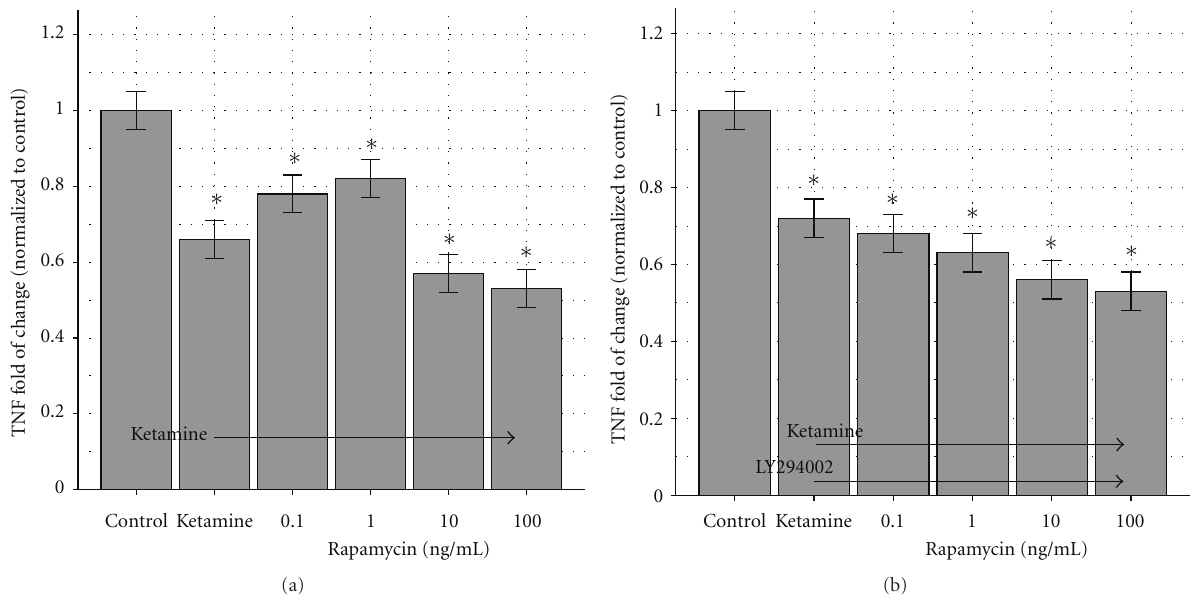
Figure 5: (a) Ketamine and rapamycin modify TNF production by RAW264.7 murine macrophages. LAC wild-type MRSA (USA300) stimulated 34% less TNF secretion by macrophages when exposed to ketamine (second column), and 43% and 47% less than the control (first column) when exposed to a combination of ketamine and rapamycin at 10ng/mL (fifth column) and 100 ng/mL (sixth column). When ketamine was combined with rapamycin at 0.1ng/mL (third column) and 1 ng/mL (fourth column), TNF production was suppressed to a lesser extent (22% and 18%, resp.). The suppression observed at 0.1 and 1ng/mL is di ff erent at P < 0 . 05 than the one observed at 10 and 100ng/mL, and all concentrations decreased TNF production compared to the control ( P < 0 . 05). The control (first column) is macrophage stimulation without ketamine or rapamycin. The results are depicted as fold of change compared to the control with 95% confidence intervals shown as “error bars.” ∗ P < 0 . 05. The control response was 29,229 ± 731 pg/mL. (b) Ketamine, rapamycin, and LY294002 modify TNF production by RAW264.7 murine macrophages. The LAC wild-type MRSA (USA300) strain stimulated less TNF secretion by macrophages when exposed to ketamine, LY294002, and rapamycin. The presence of LY294002 abolished the dose response depicted in Figure 8. Specifically, the reduction with ketamine and LY294002 was 28% (second column). Ketamine plus LY294002 and rapamycin at 0.1ng/mL (third column) and 1ng/mL (fourth column) caused reductions of 32% and 37%, respectively. With rapamycin doses of 10 ng/mL (fifth column) and 100ng/mL (sixth column), the reductions were 44% and 47%. Ketamine with low doses (0.1 and 1ng/mL) of rapamycin did not give results significantly di ff erent from ketamine alone, but higher doses (10 and 100 ng/mL) caused augmented TNF suppression ( P < 0 . 05). The control was macrophage stimulation without ketamine, rapamycin, or LY294002, and the second column shows RAW264.7 cell stimulation in the presence of ketamine only. The results are depicted as fold of change compared to the control with 95% confidence intervals shown as “error bars.” ∗ P < 0 . 05. The control response was 28,445 ± 701